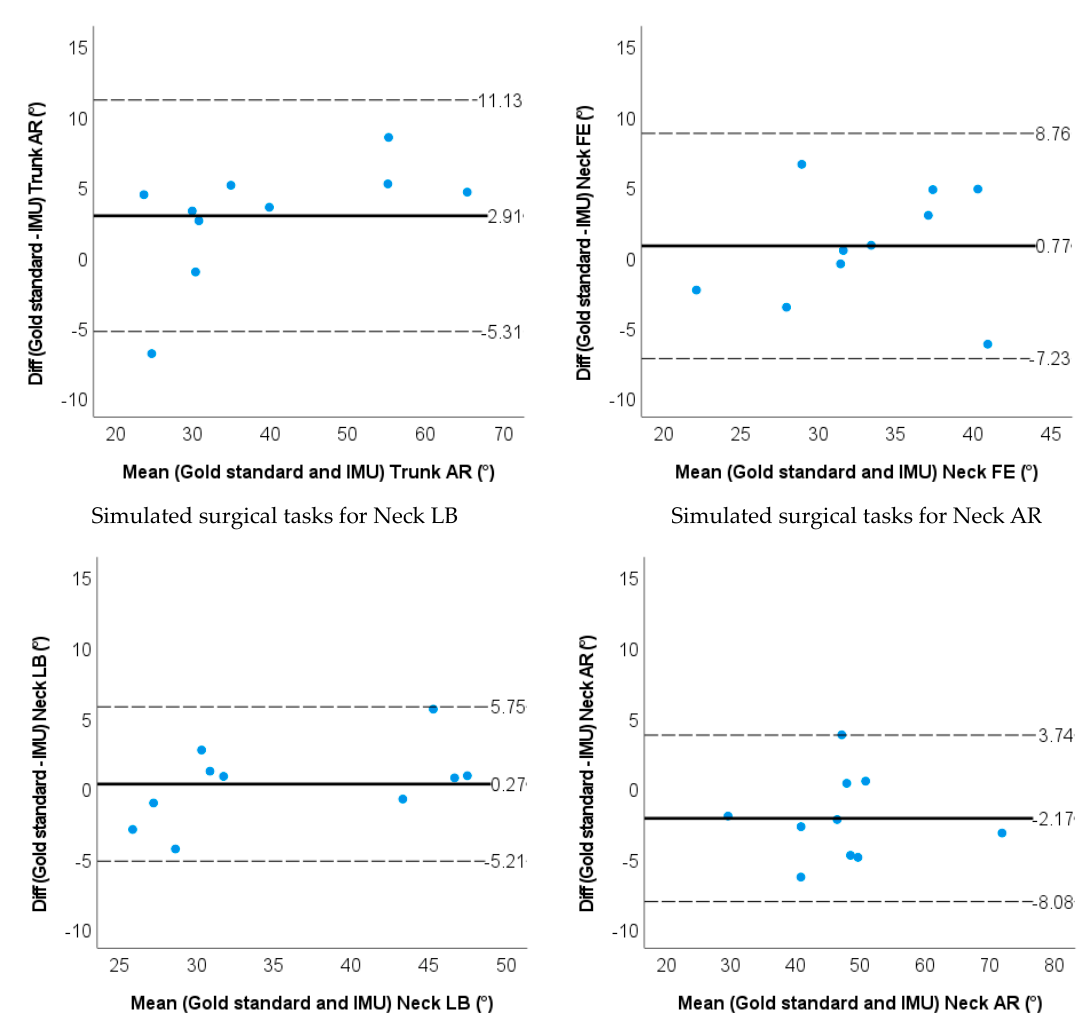
Figure 8. Bland − Altman plots for ROM of the trunk and neck angle obtained by the gold standard and IMU method for the simulated surgical tasks. The solid line represents the mean difference, and the dashed line represents the 95% limits of agreement. Table 3. ICC (2,1) of ROM for the IMU/Markerless method.